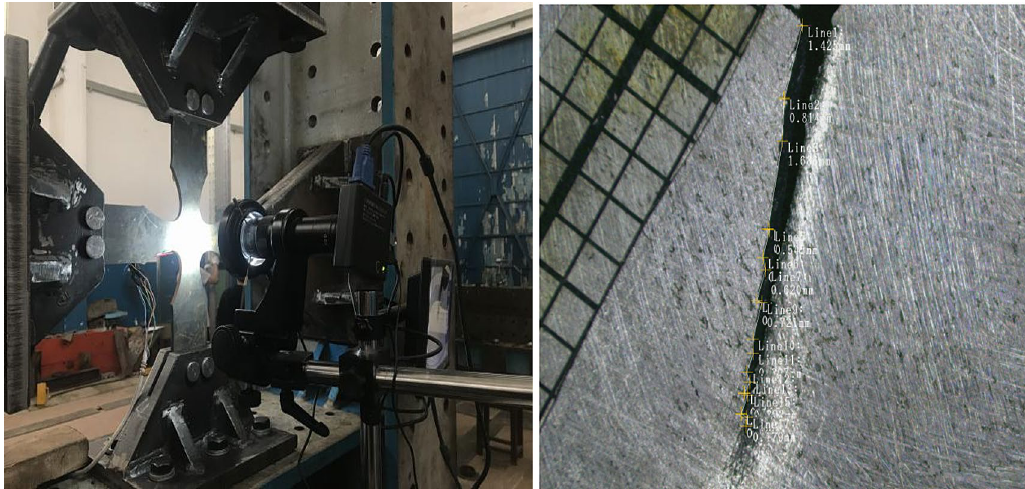
Fig. 4 CCD Camera and its measurement image